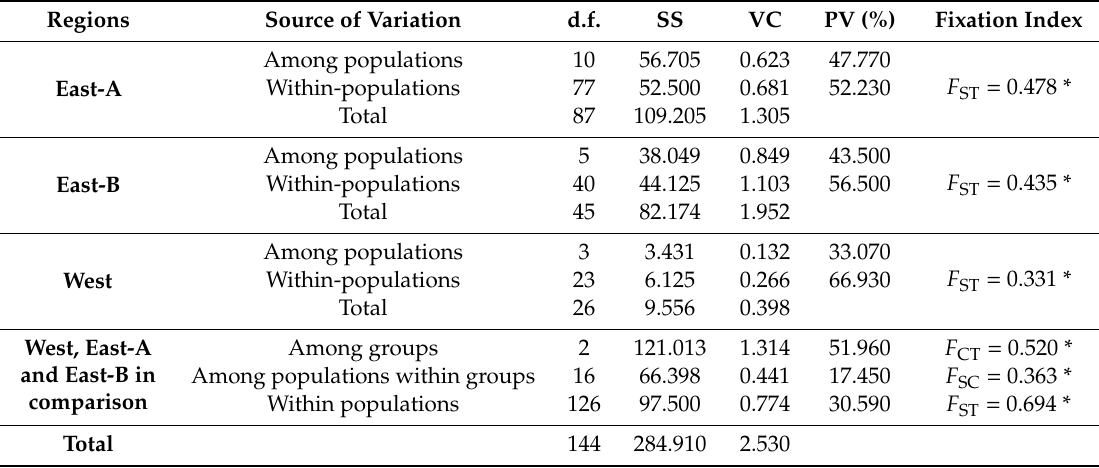
Table 3. Calculation of molecular variance for chlorotype sequences of Nitraria tangutorum . d.f., degrees of freedom; SS, sum of squares; VC, variance component; PV, percentage of variation; * p < 0.05.